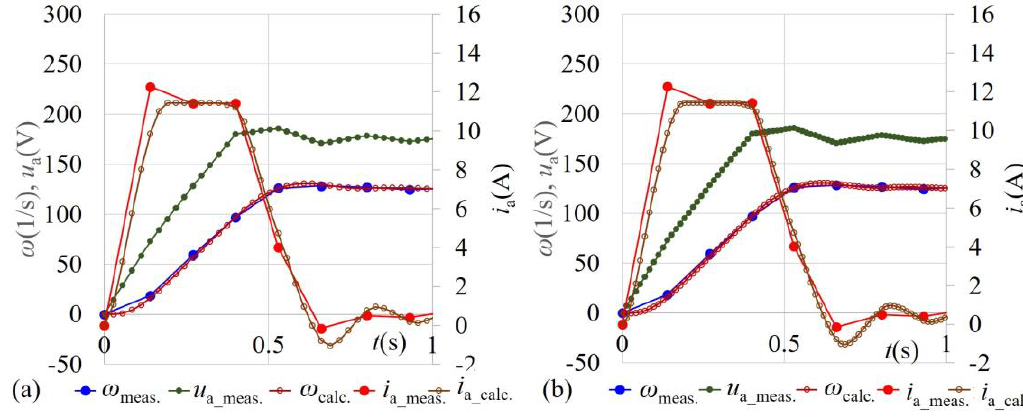
Figure 19. Measured and calculated responses in the case of MD1 using: ( a ) RK5; ( b ) RK10. Comparing Figures 8 and 18, the improvement achieved with EM5 and EM10 can be seen. The simulated responses were closer to the measured responses.